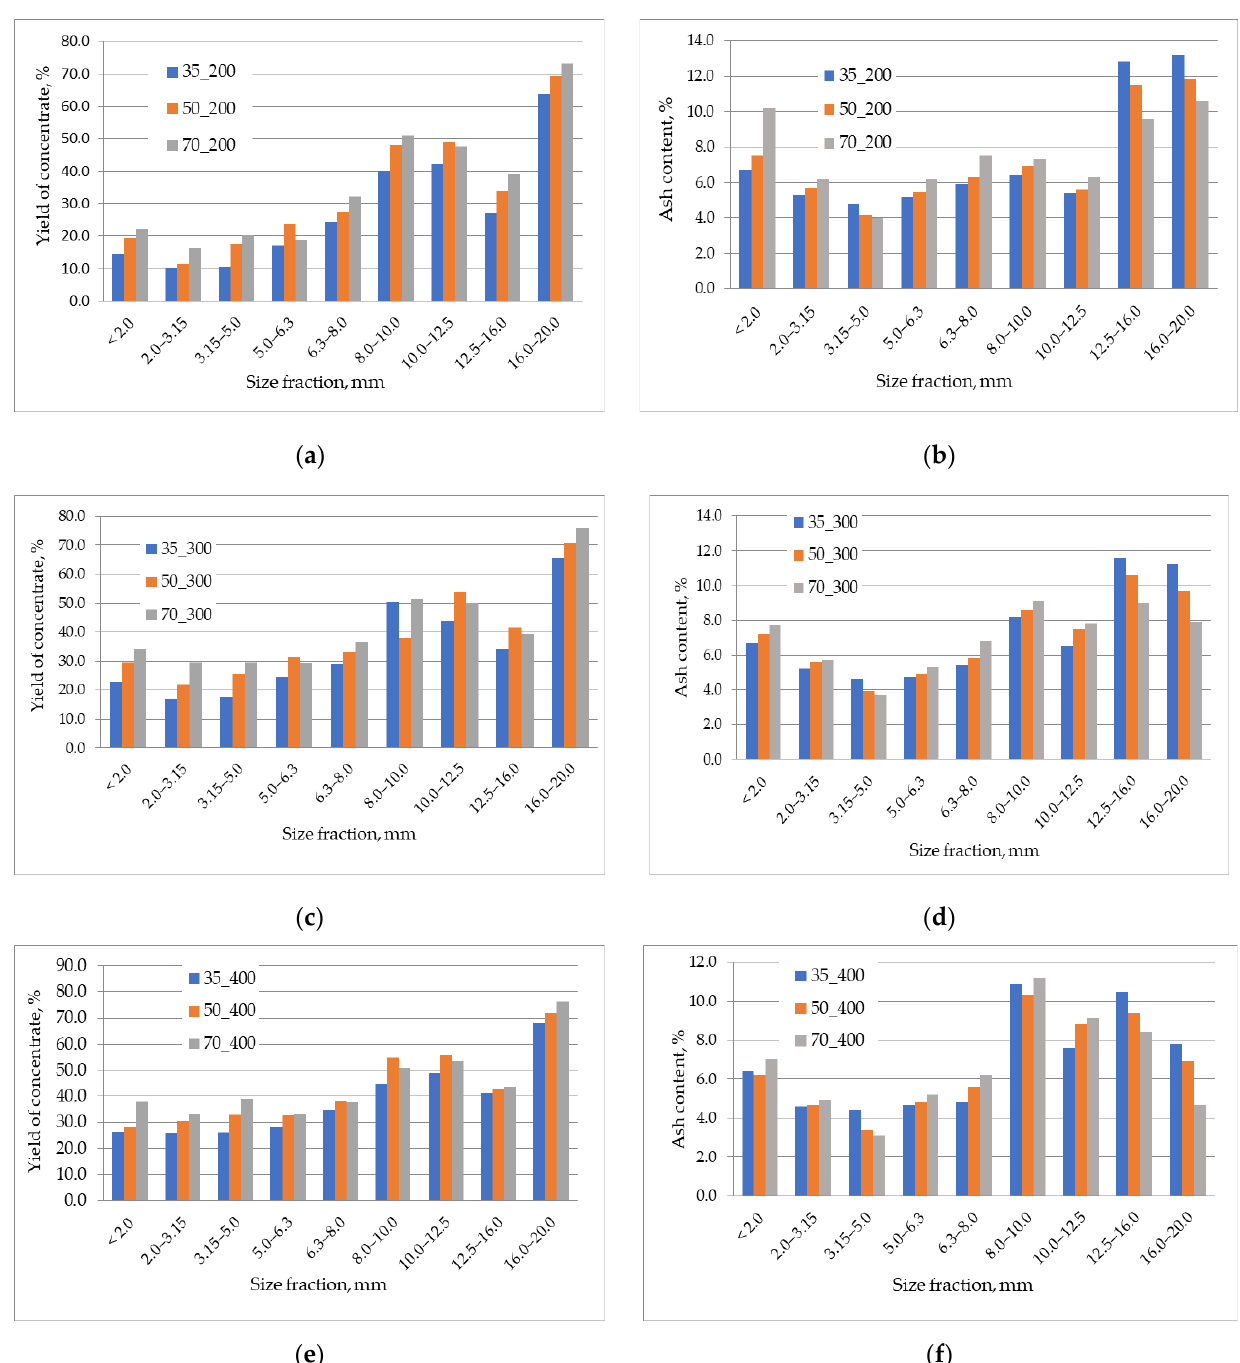
Figure 3. Concentrate yield and ash contents in the concentrate as a function of particle size fraction: ( a ) yield of concentrate — throughput 200 t/h, ( c ) yield of concentrate — throughput 300 t/h, ( e ) yield of concentrate — throughput 400 t/h, ( b ) ash content — throughput 200 t/h, ( d ) ash content — throughput 300 t/h, ( f ) ash content — throughput 400 t/h.